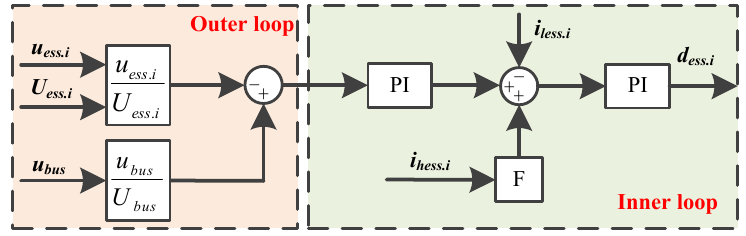
Figure 4. Improved control block